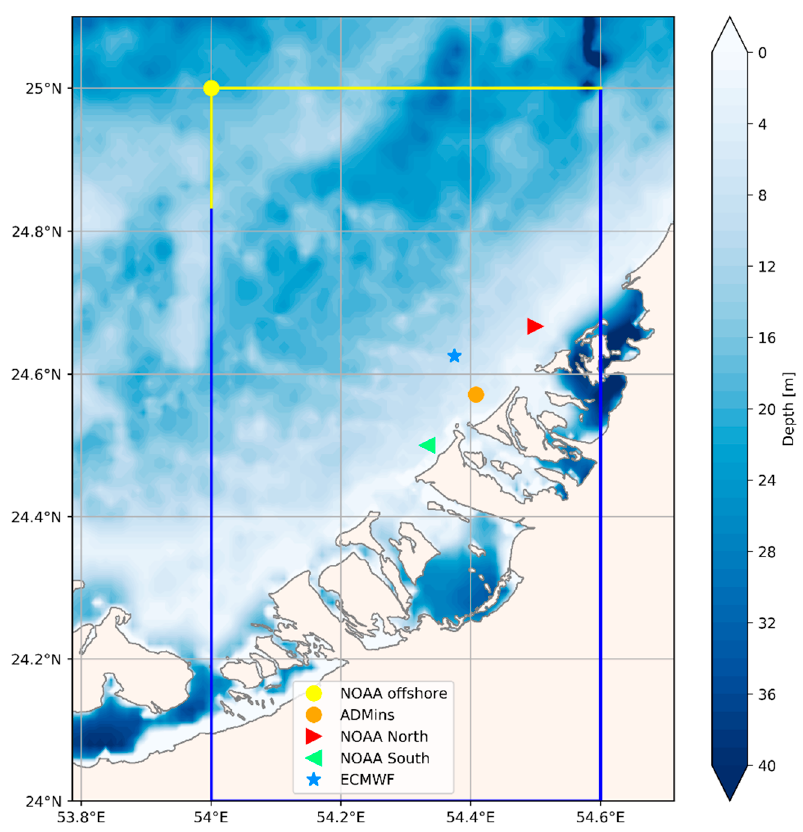
Figure 3. Bathymetry of the Saadiyat area, where markers show the position of ADM ins , the NOAA N, the NOAA S, the NOAA offshore and the ECMWF model nodes.